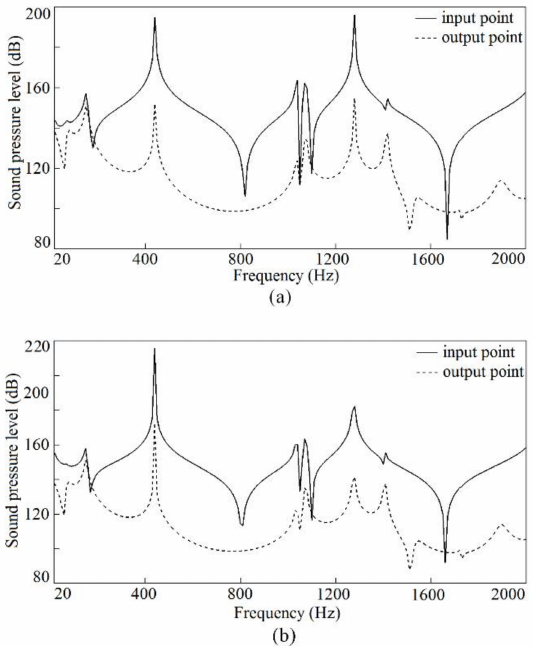
Figure 16. The sound pressure level of the inlet and outlet of the silencer ( T = 760 K): ( a ) v = 20 m/s; ( b ) v = 35 m/s.